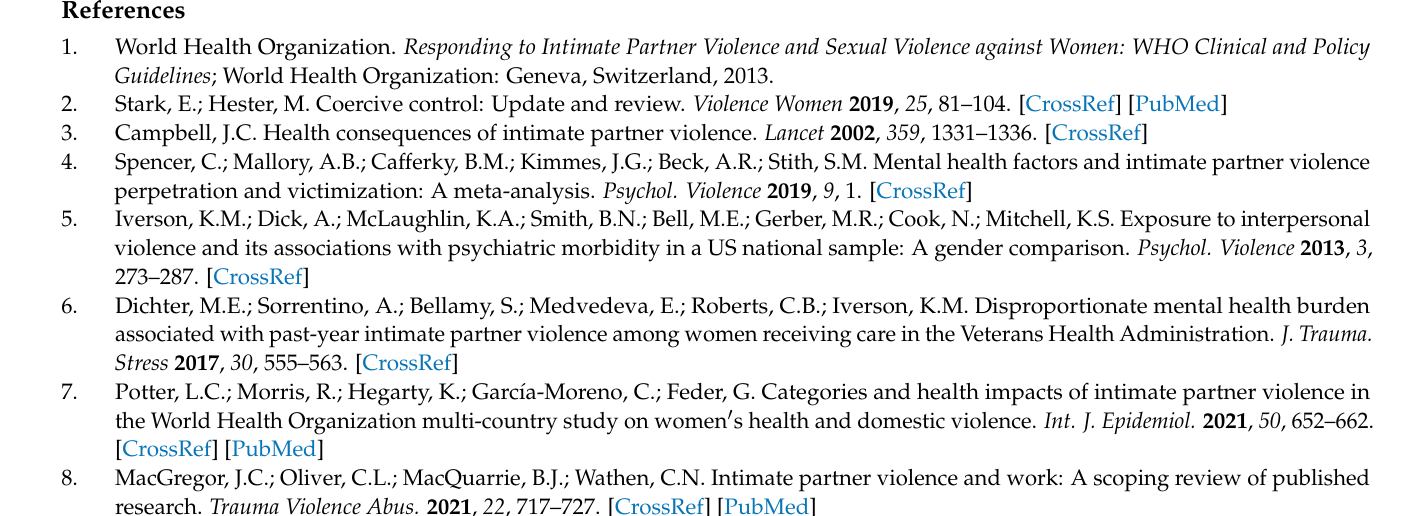
Data; Table S3: Summary of eligible studies; Table S4: Characteristics of studies of IPV impact and context (including coercive and controlling behaviours); Table S5: Risk of bias of eligible studies; Table S6: Sensitivity analysis comparing studies classified as low risk of bias and high risk of bias for any current IPV perpetration and any current IPV victimisation; Table S7: Sensitivity analysis comparing the original analysis of any current IPV perpetration and any current IPV victimisation, and the analyses with outliers